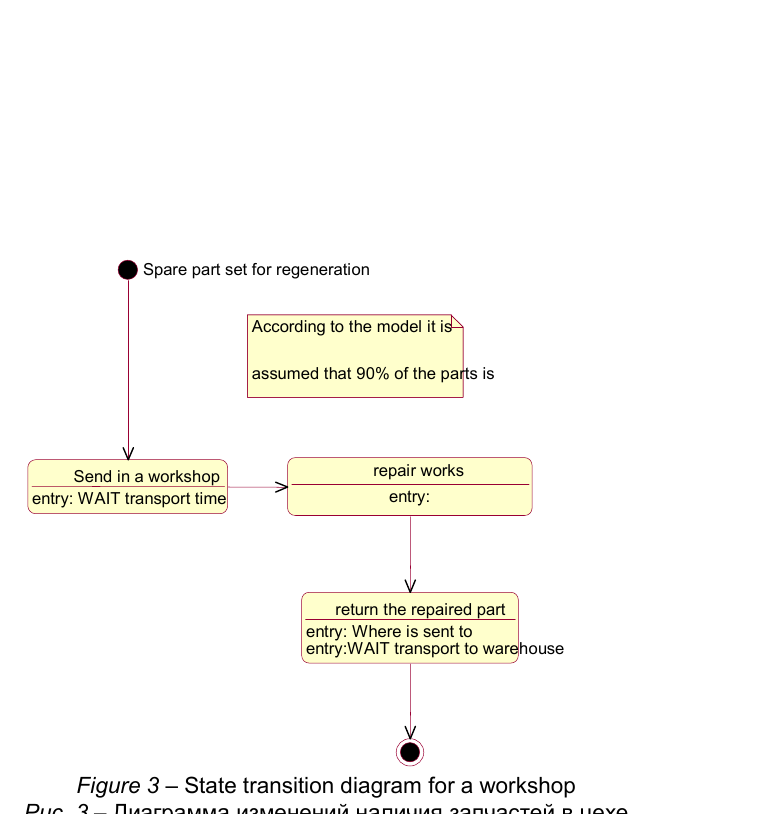
Figure 3 – State transition diagram for a workshop Рис . 3 – Диаграмма изменений наличия запчастей в